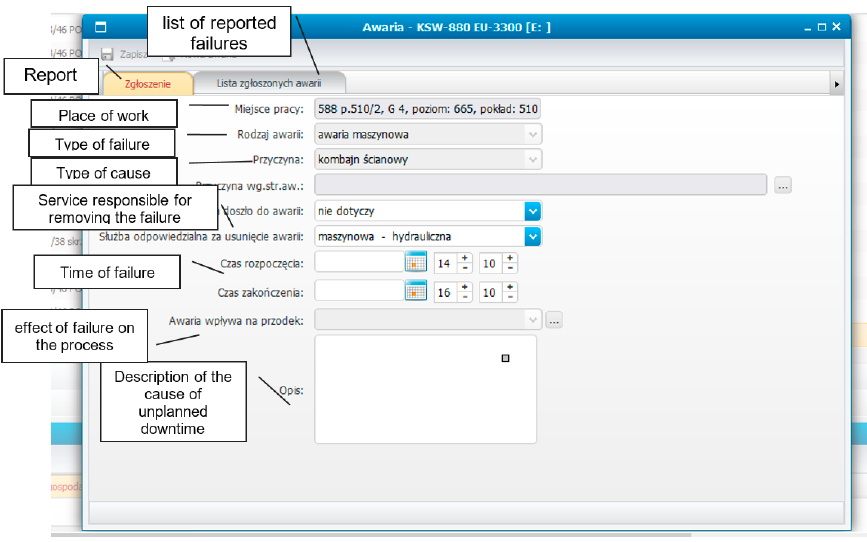
Figure 3. The view of an IT tool card for recording unplanned machine downtime.